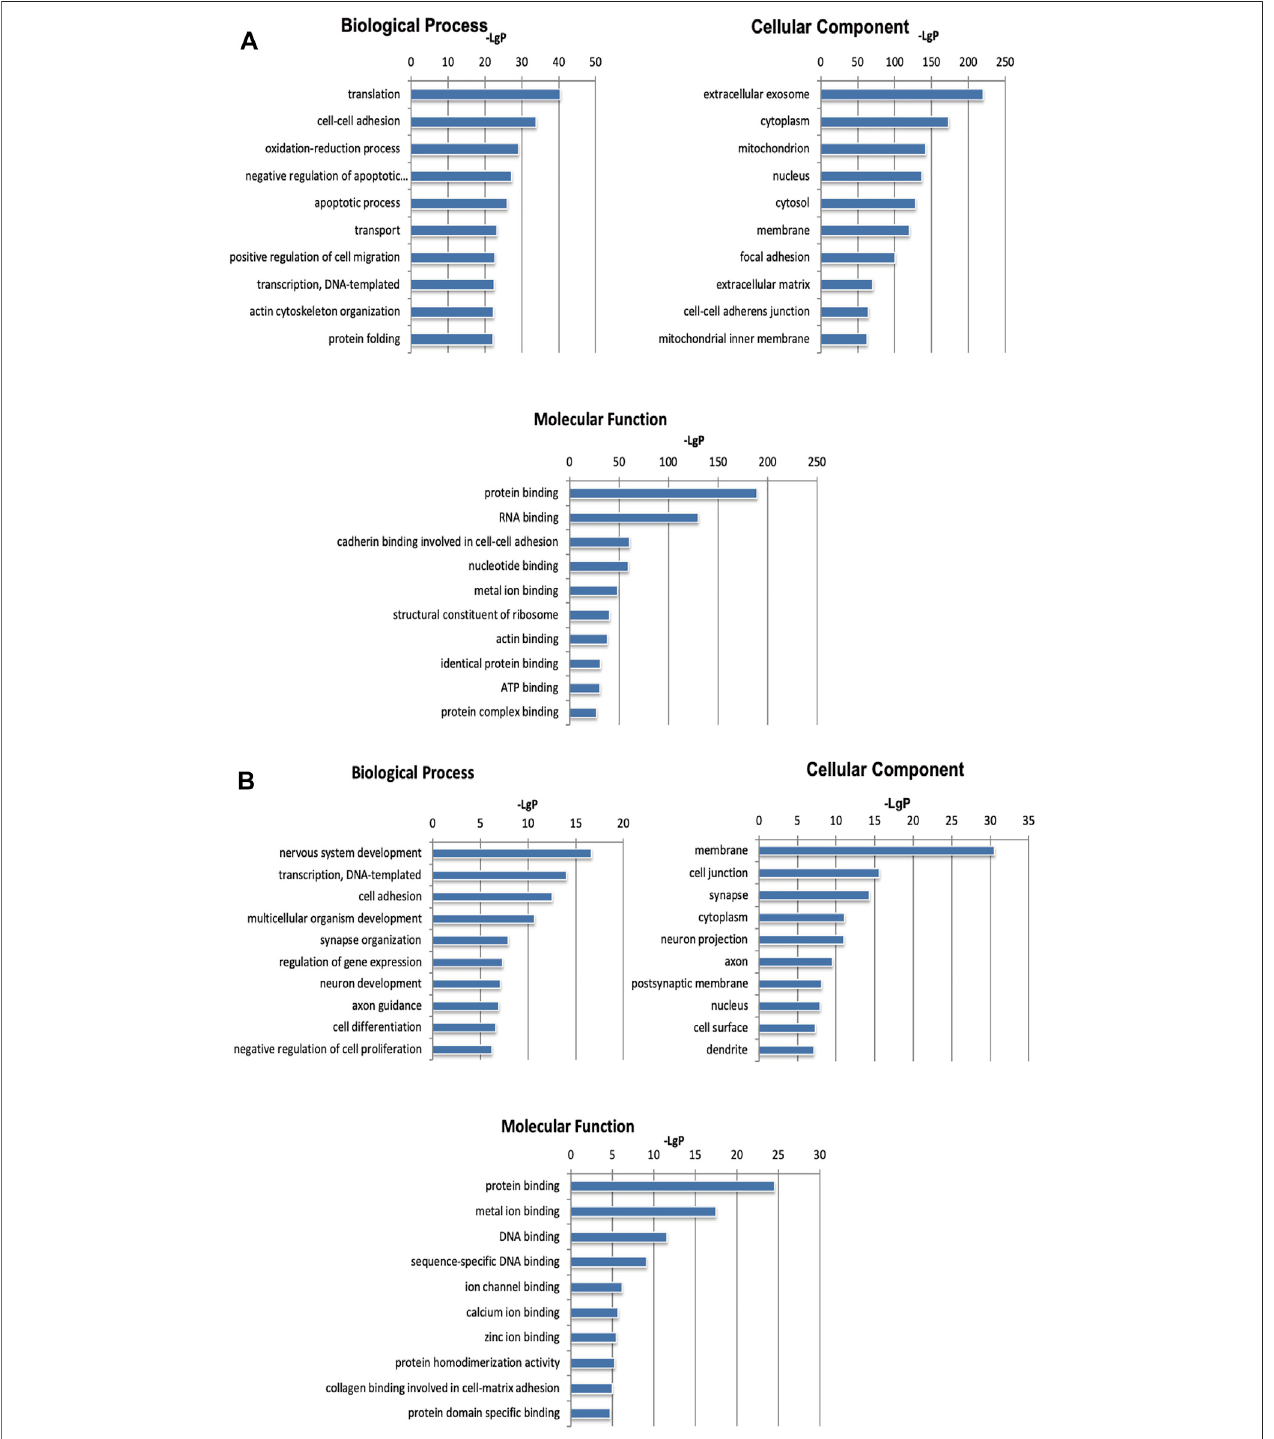
FIGURE3| GOanalysisofdifferentiallyexpressedmRNAsandmicroRNAsinducedbyCIH. (A) GOenrichmentanalysisformRNAs. (B) GOenrichmentanalysisfor microRNAs. The abscissa is -LgP. The bigger the -LgP, the smaller the p -value.